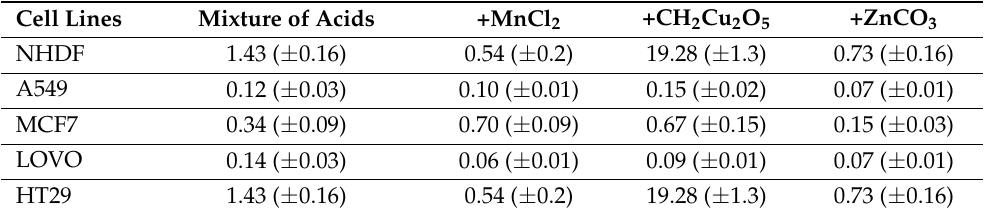
Table 15. IC 50 values against normal and tumour lines incubated for 48 h with essential oil of Ceylon cinnamon ( Cinnamomum verum J. Presl) and the components used in the study. Cell Lines